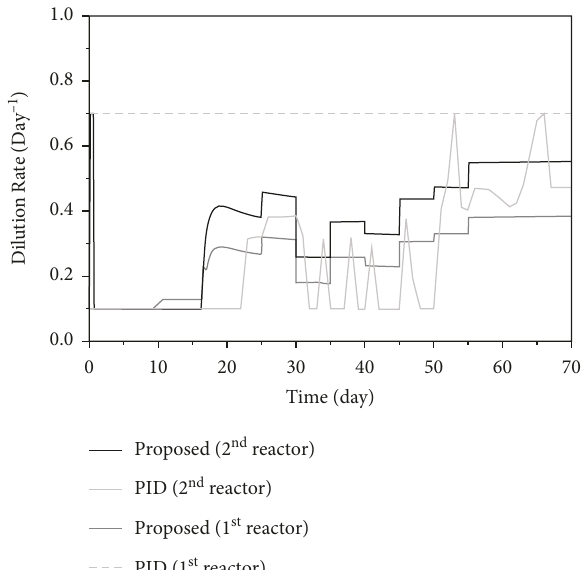
Figure 11: Dilution rate profiles corresponding to Figure 10.